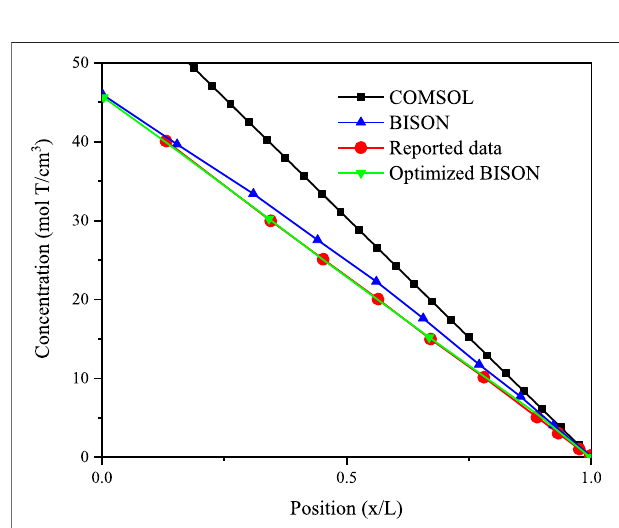
FIGURE 3 | Tritium distribution at the radial direction in the FeCrAl cladding of simulated and experimental results at 120,000 s, and concentrations are times 10 12